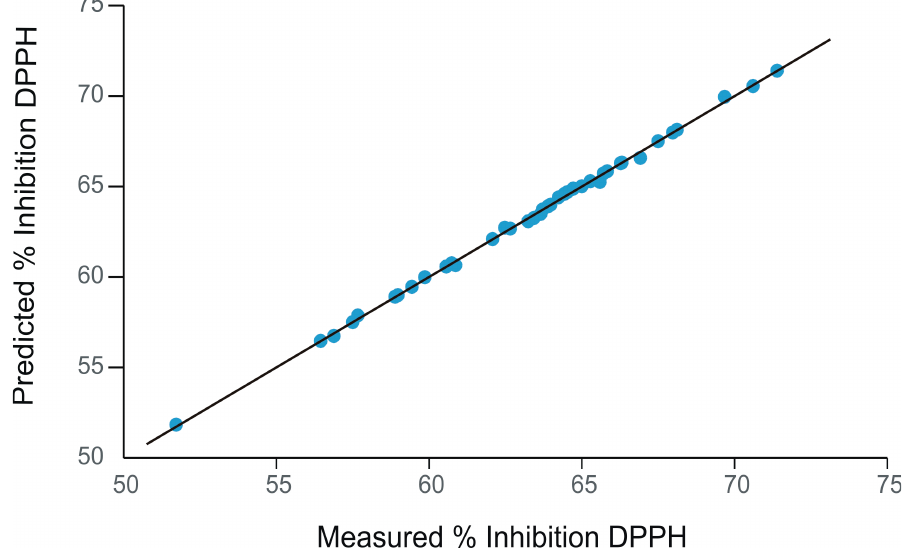
Figure 7. Plot of predicted % inhibition of DPPH from the voltammetric data vs. measured % inhibition of DPPH obtained from the spectrophotometric methods. The averages of six replicates corresponding to each oil sample were included in the regression models.